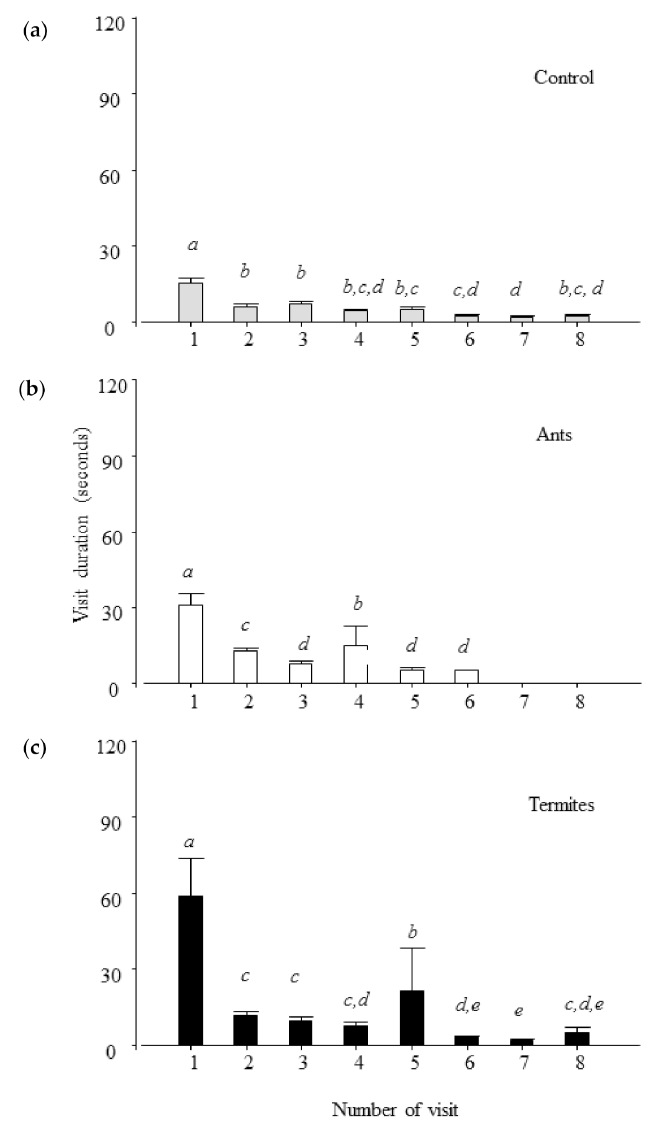
Figure 3. Average duration of each visit of a lesser anteater to the ( a ) control feeder, ( b ) feeder with ants, and ( c ) feeder with termites during the behavioral evaluation (10 min sessions per anteater; 3 evaluations for each animal). Different letters within each panel indicate statistical differences between the duration of the visits of the lesser anteaters to each feeder ( p <